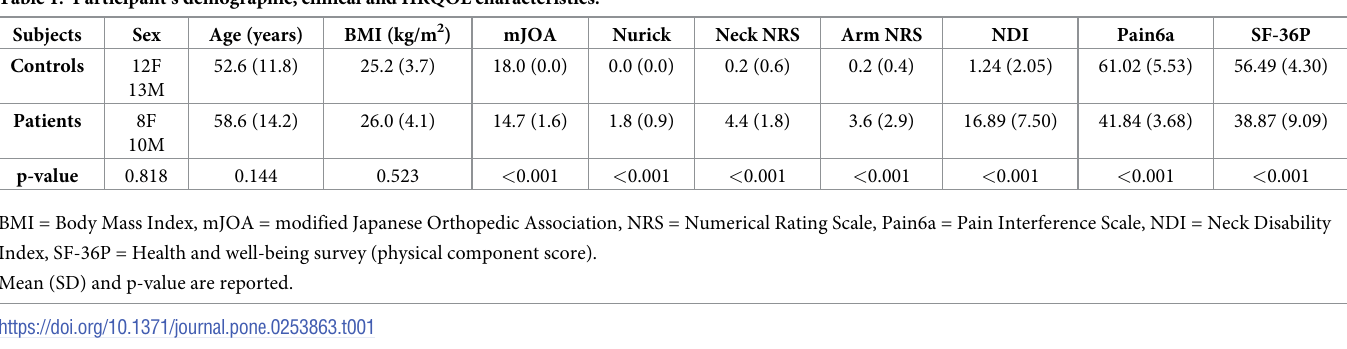
Muscle fat infiltration and its association with clinical and HRQOL scores Muscle fat infiltration in the deeper cervical muscle groups such as MFSS, and LC differed sig- nificantly between patients with DCM and healthy controls. Specifically, patients with DCM had significantly higher MFI in LC as compared to controls (Right LC- 18.57 ± 7.01 vs 13.27 ± 4.74, p = 0.010, Left LC- 18.91 ± 7.38 vs 14.04 ± 5.20, p = 0.023, Mean LC- 18.74 ± 6.7 vs 13.66 ± 4.91; F (1, 38) = 5.81, p = 0.021, partial η 2 = 0.133) after controlling for age, sex and BMI (covariates evaluated at age = 55.12, sex = 0.53 and BMI = 25.50) [Fig 2a]. There was a sta- tistically significant between-subject effect of age (F (1, 38) = 17.19, p < 0.001, partial η 2 = 0.311) and BMI (F(1, 38) = 6.82, p = 0.013, partial η 2 = 0.152) but not sex (F(1, 38) = 1.31, p = 0.260, partial η 2 = 0.033) on MFI. Similarly, patients with DCM had significantly higher MFI in MFSS as compared to controls (Right MFSS- 20.58 ± 5.84 vs 16.88 ± 5.34, p = 0.046, Left MFSS- 20.69 ± 5.27 vs 17.20 ± 5.31, p = 0.048, Mean MFSS- 20.63 ± 5.43 vs 17.04 ± 5.24; F (1, 35) = 1.38, p = 0.043, partial η 2 = 0.138) after controlling for age, sex and BMI (covariates evaluated at age = 55.75, sex = 0.50 and BMI = 25.47) [Fig 2b]. There was a statistically signifi- cant between-subject effect of age (F (1, 35) = 11.35, p = 0.002, partial η 2 = 0.245) and BMI (F (1, 35) = 9.80, p = 0.004, partial η 2 = 0.219) but not sex (F (1, 35) = 1.67, p = 0.205, partial η 2 = 0.046) on MFI. There were no significant differences in MFI levels between patients with DCM and con- trols in SPCap (8.91 ± 4.78 vs 8.05 ± 4.74, (p = 0.562)), SSCap (15.58 ± 5.15 vs 14.22 ± 4.92, (p = 0.385)), SCM (8.70 ± 4.90 vs 6.81 ± 3.88, (p = 0.164)), TR (6.66 ± 4.09 vs 5.45 ± 4.14, (p = 0.344)), and LS (5.35 ± 3.50 vs 4.68 ± 3.48, (p = 0.541)) muscle groups [Table 2]. Increased MFI was significantly associated with clinical disability, pain, and physical dys- function. Patients with elevated Nurick scores had significantly higher MFI in LC (Spearman’s ρ = 0.436 (p = 0.003)), (F (3, 36) = 3.53, p = 0.024, partial η 2 = 0.228) [Fig 3a]. Patients with lower mJOA scores had significantly higher MFI in LC (Spearman’s ρ = -0.399 (p = 0.008)). Healthy controls (mJOA = 18, MFI- LC = 13.65 ± 4.90) had lower MFI than patients with mild disability (17 � mJOA � 15, MFI- LC = 18.48 ± 7.52) and moderate disability (14 � mJOA � 12, MFI- LC = 19.0 ± 6.25), (F (2, 37) = 3.60, p = 0.037, partial η 2 = 0.163) after adjusting for age, sex and BMI (covariates evaluated at age = 55.12, sex = 0.53, BMI = 25.50) [Fig 3b]. Increased MFI in MFSS were significantly associated with increasing Nurick scores ( ρ = 0.341 (p = 0.031)) and decreasing mJOA scores ( ρ = -0.332 (p = 0.036)). Similar associations were observed between MFI and HRQOL scores such as NDI ( ρ = 0.432 (p = 0.004)), Pain6a ( ρ = 0.335 (p = 0.035)), and SF36-P ( ρ = -0.420 (p = 0.026)) [Table 3]. Age and BMI had a signifi- cant association with MFI in both healthy controls and patients with DCM. Specifically, MFI levels increased with increasing age and BMI in both groups [Fig 4a and 4b].